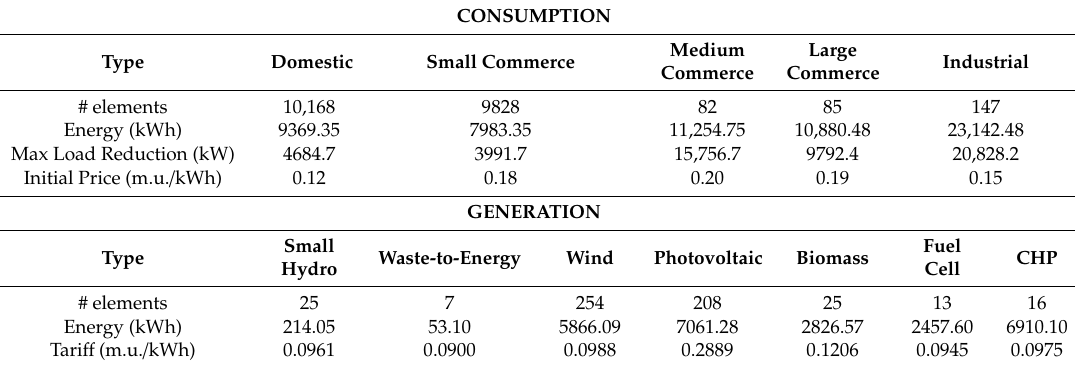
Table 1. Small resources characterization in the ten communities.